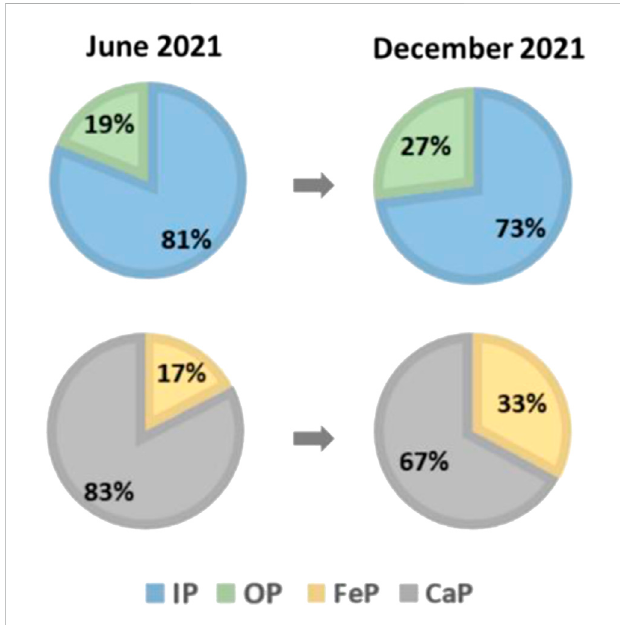
FIGURE 6 Proportions of P forms in the sediments in the two